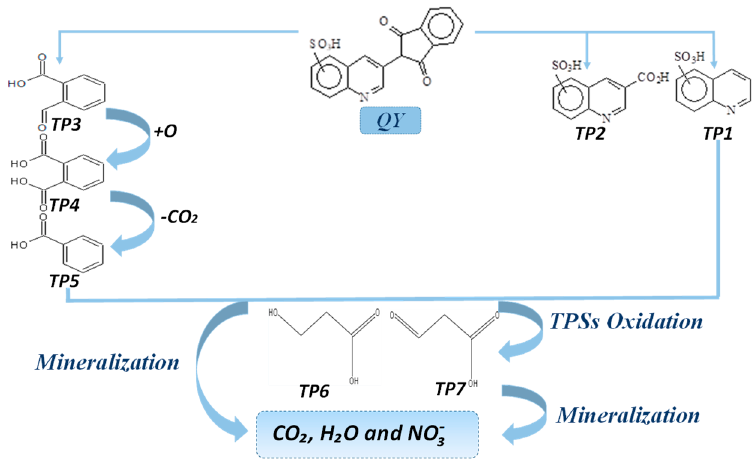
Figure 11. Proposed degradation mechanism for QY in Ag 3 PO 4 process.